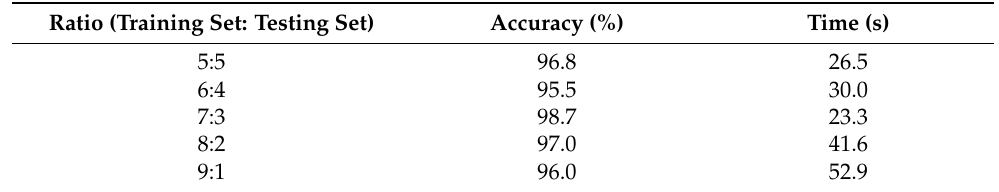
Table 3. Results of different training and testing ratios.